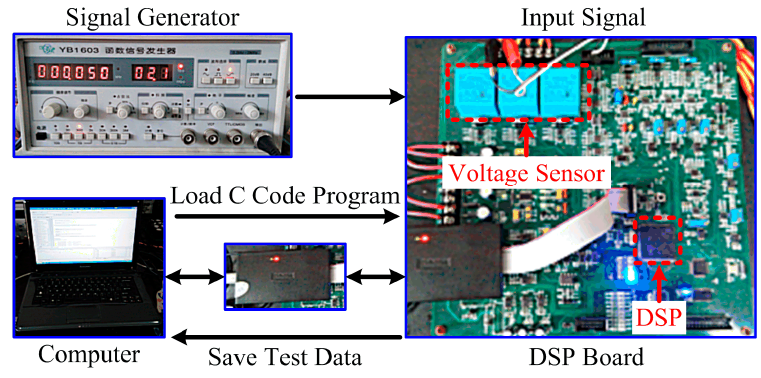
Figure 11. The experimental platform.